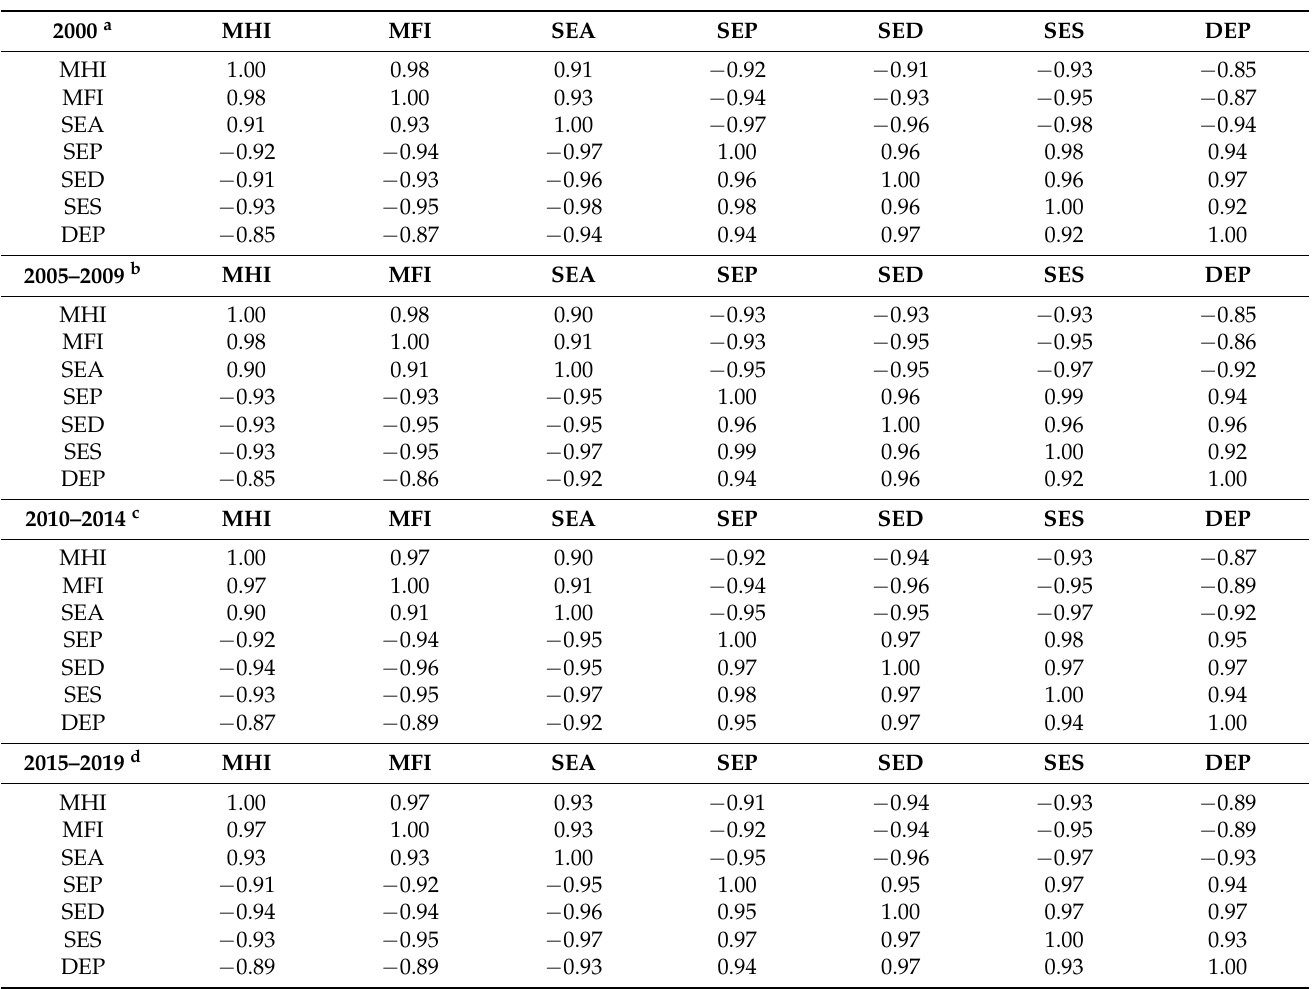
Table 10. Relationships between simple and composite measures of neighborhood socioeconomic status in the Fresno Metropolitan Statistical